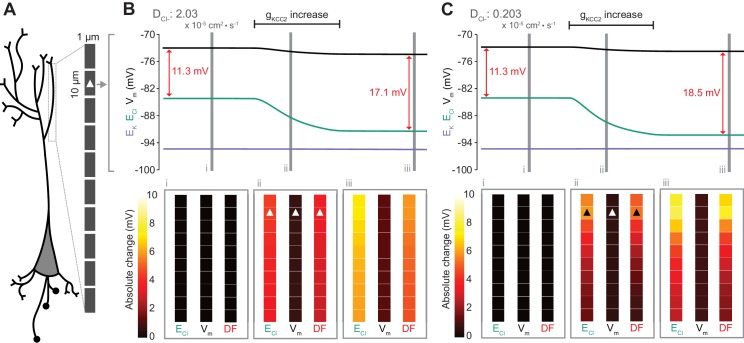
Local changes in KCC2 activity generate local differences in chloride reversal and driving force only under conditions of constrained chloride diffusion.(A) Schematic depicting the multi-compartment model representing a virtual dendrite of length 100 μm. The virtual dendrite consists of 10 compartments of length 10 μm and initial radius 0.5 μm. Each compartment contains the same mechanisms and default parameterization as the single compartment model. All ions, except impermeant anions, could move between compartments by electrodiffusion. (B) Top panel, ECl (green), EK (purple), Vm (black) and DF (arrows, red) from the second from top compartment (indicated with a white triangle) where the conductance of KCC2 was increased. The insets depict the diameter, and absolute change from baseline of ECl, Vm and DF for all compartments before (i), during (ii) and after (iii) the activity of KCC2 was selectively increased. This resulted in ECl decreasing in all compartments with minimal changes to EK and V. Consequently, the Cl- DF (red) increased. In this case the diffusion constant for Cl- (DCl = 2.03×10−7 dm2.s−1) resulted in ECl and DF changes being widespread across the virtual dendrite. (C) Reducing the Cl- diffusion constant to 0.2 × 10−7 dm2.s−1 resulted in a localized effect of compartment-specific KCC2 activity increases on ECl and DF.